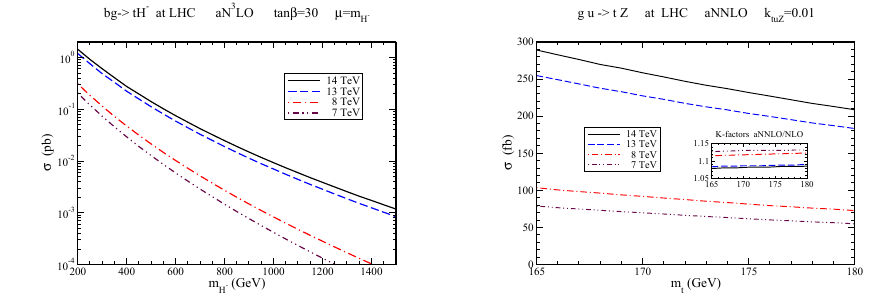
Figure 3. (Left) aN 3 LO cross sections for tH − production. (Right) aNNLO cross sections for tZ production via anomalous